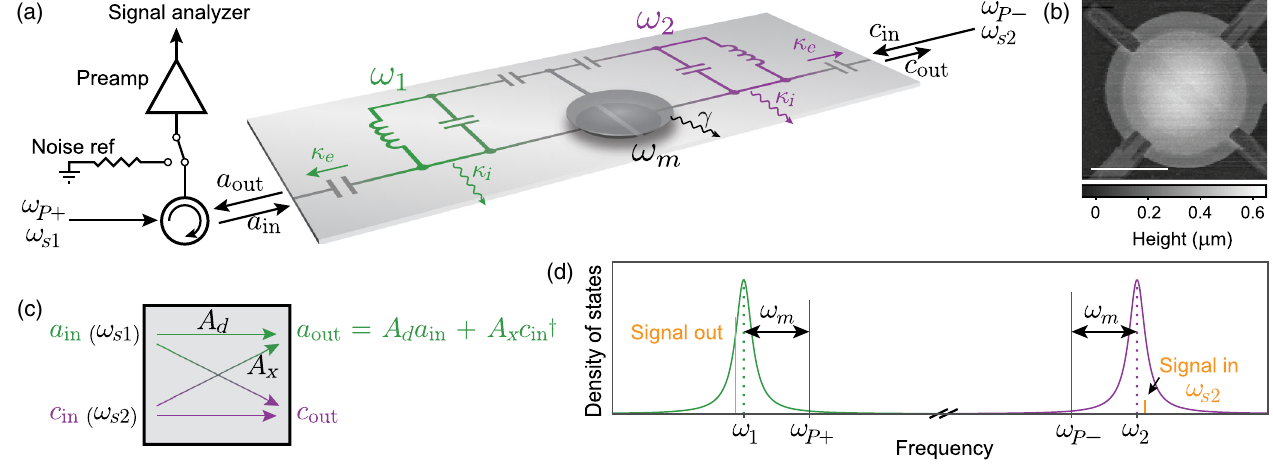
FIG. 1. Experimental setup. (a) Schematic of our device, showing two LC microwave cavities ( ω 1 , ω 2 ) both coupled to a central mechanical drumresonator( ω ) aswell asan individualfeedline. Signals( ω m The output of cavity 1 is preamplified and measured with a signal analyzer. (b) Atomic force micrograph of the drum resonator. Scale bar is 10 μ m long. (c) Conceptual two-port amplifier, exhibiting both direct ( A modes and pump frequencies used to realize a two-port amplifier. As an example, an input signal with frequency ω with the frequency-converted and amplified output emerging from cavity